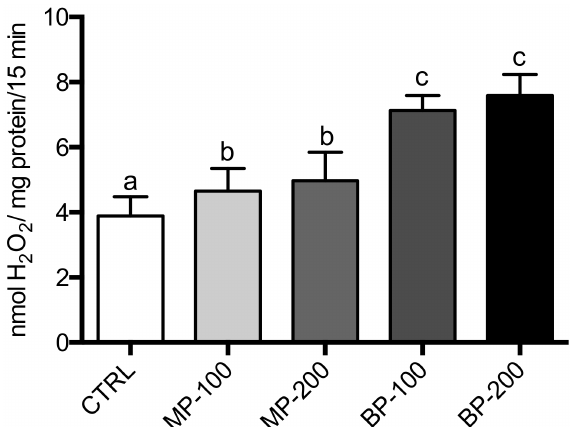
Figure 5. Production of hydrogen peroxide by functional mitochondria isolated from testes of F1 generation. The results are expressed as nmol H 2 O 2 / mg protein / 15 min and are represented as M ± SD of 7–10 independent experiments performed with di ff erent mitochondrial fractions performed in duplicate. The values marked with the same letter are not statistically significant between groups as determined by the Tukey’s post hoc test ( p <